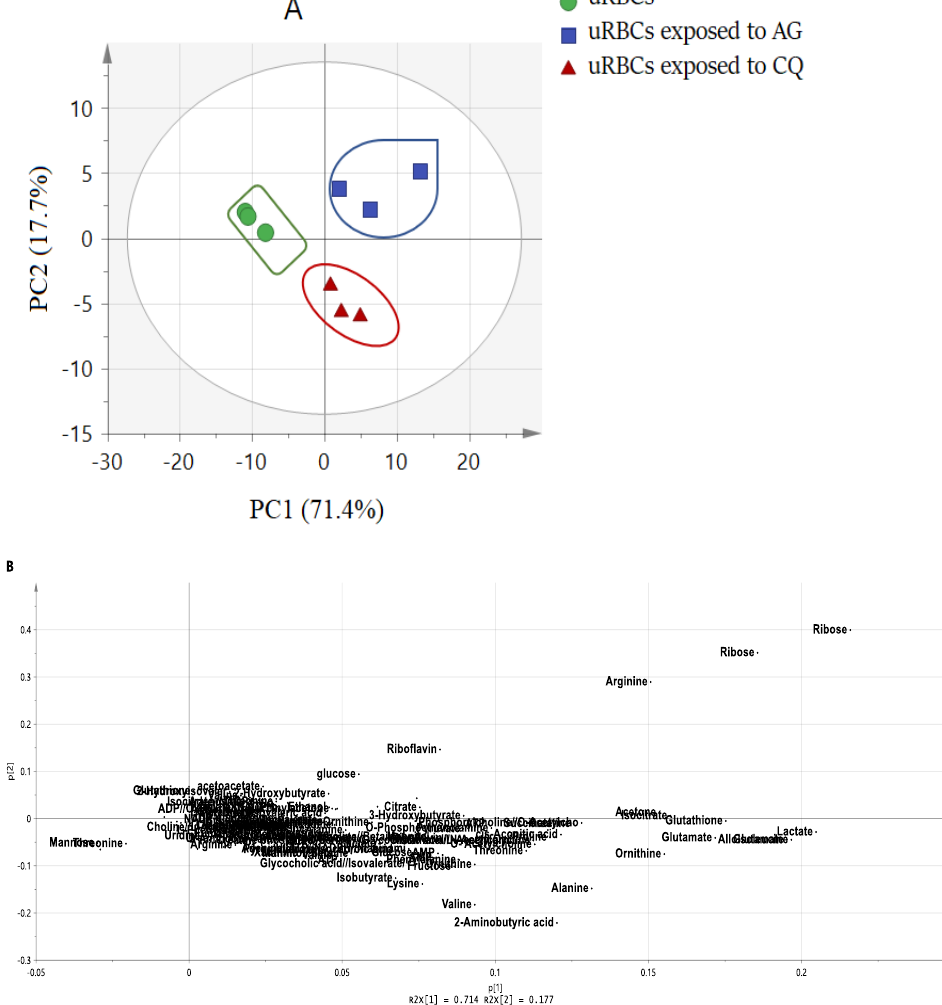
Figure 2. Principal component analysis (PCA) of the uninfected red blood cells ’ metabolic profiles: ( A ) score scatter plot (PC1 vs. PC2), ( B ) the loading scatter plot, uRBCs; uninfected red blood cells, AG; andrographolide, CQ; chloroquine.